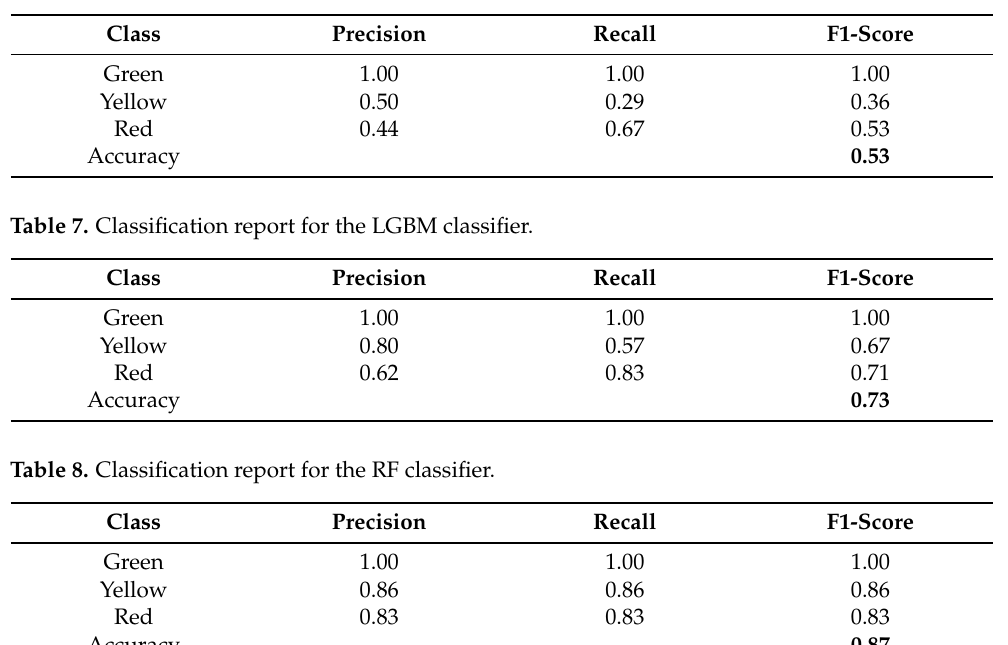
Table 6. Classification report for the DT classifier.